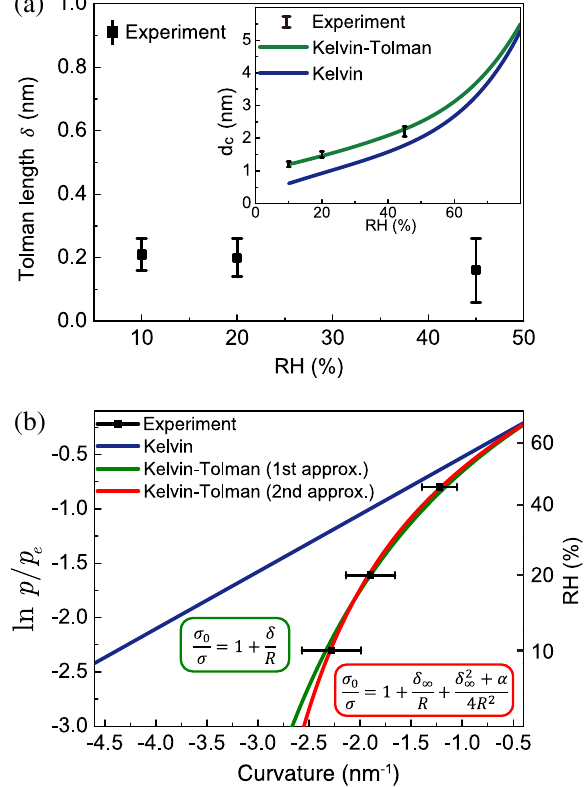
FIG. 8. (a) The Tolman length is derived for the measured d at a c given RH by fitting the equilibrium value of 1 =R in the first-order Kelvin-Tolman equation [Eq. (3)]. The inset shows the exper- imental d and the theoretically calculated d using the Kelvin- c c Tolman equation ( δ ¼ 0 . 2 nm, green curve) and the Kelvin equation with constant surface tension (blue curve). (b) Equilib- rium curvature ( ¼ 1 =R ) is calculated from the d measurements. c The green curve represents the first-order Kelvin-Tolman equation with δ ¼ 0 . 2 nm [same as in the inset of (a)], whereas the red curve is fitted on the second-order equation with δ ∞ ¼ 0 . 13 nm and þ α ¼ − 0 . 14 nm, which are reasonably consistent with the δ 2 ∞ homogeneous-nucleation measurements